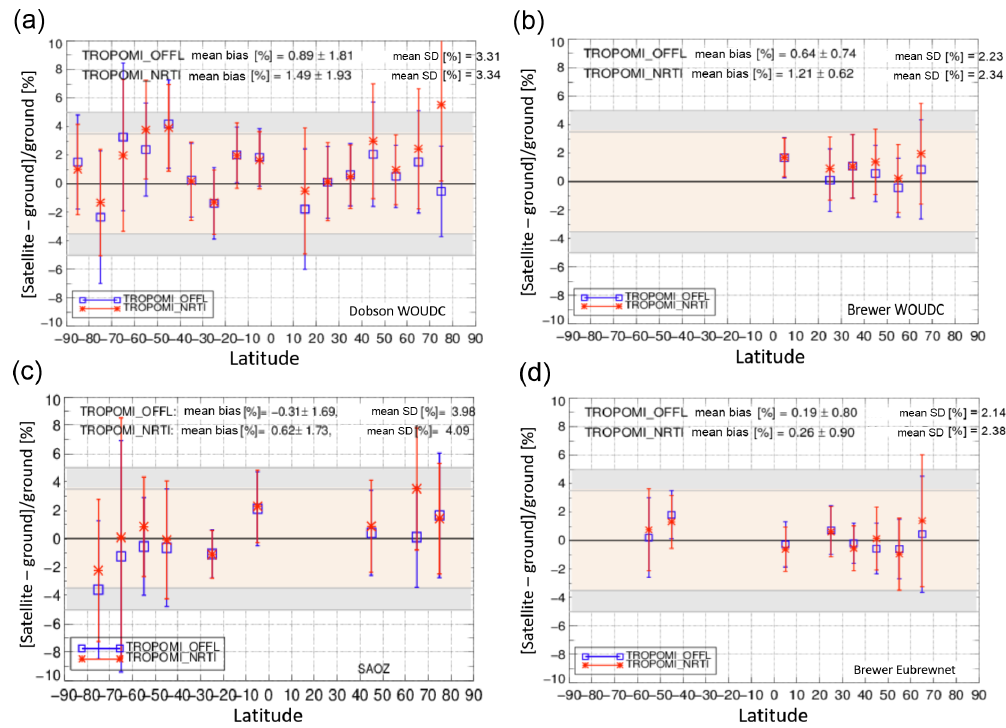
Figure 7. The latitudinal dependency of the mean percentage differences: (a) Dobson and (b) Brewer from WOUDC, (c) SAOZ and (d) Brewer from Eubrewnet, and their standard deviations for the two TROPOMI TOC products (blue line: OFFL; red line: